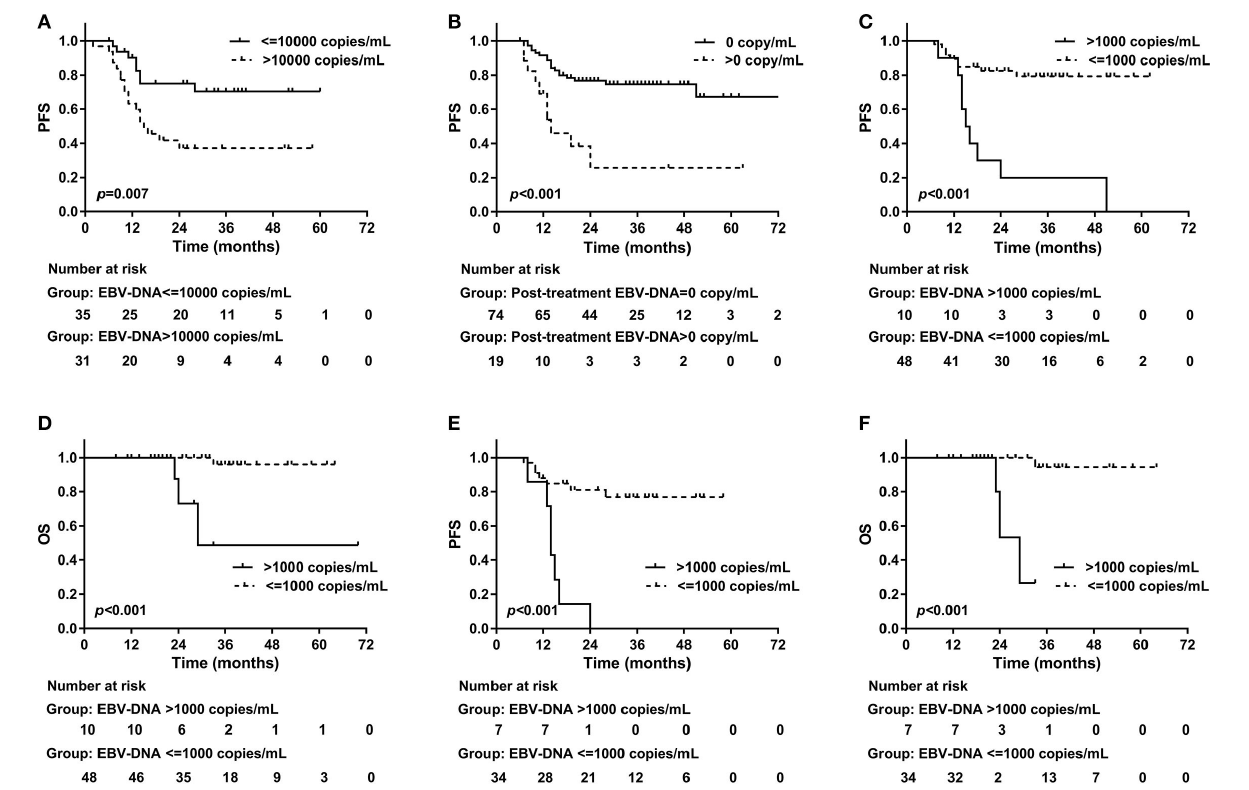
Frontiers in Oncology |